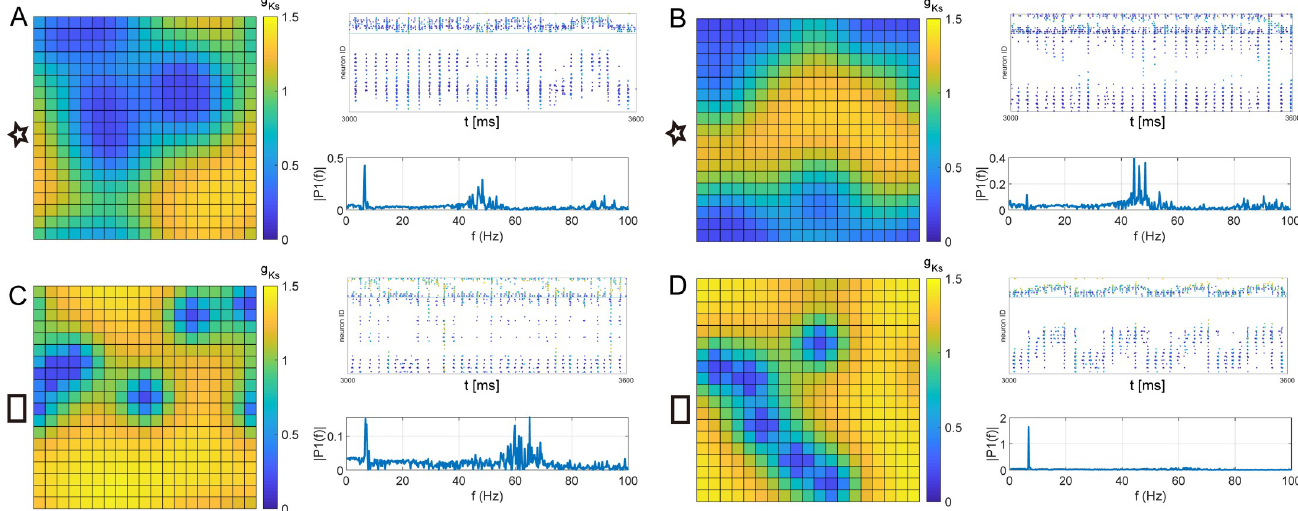
Fig 5. Examples of variability in theta/gamma rhythms for randomly generated spatial g distributions. The g spatial mappings (color plots), network spike Ks Ks raster plots (right panels, top) and network frequency power spectrum (right panels, bottom) for two pairs ( A, B and C, D ) of g Ks map realizations with the same mappings with 6 hotspots of radius r = 5.4 (marked by ’star’ in S5 Fig). C, D The results of 2 random g sets of parameters. A, B The results of 2 random g Ks Ks mappings with 6 hotspots of radius r = 2.8 (marked by ’square’ in S5 Fig).